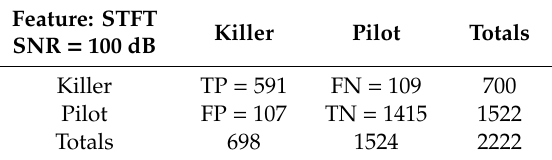
Table 3. Classification results: STFT, SNR = 100 dB.